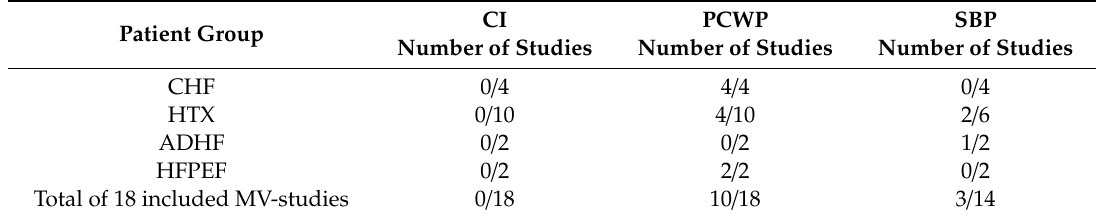
Table 3. MV analysis summary